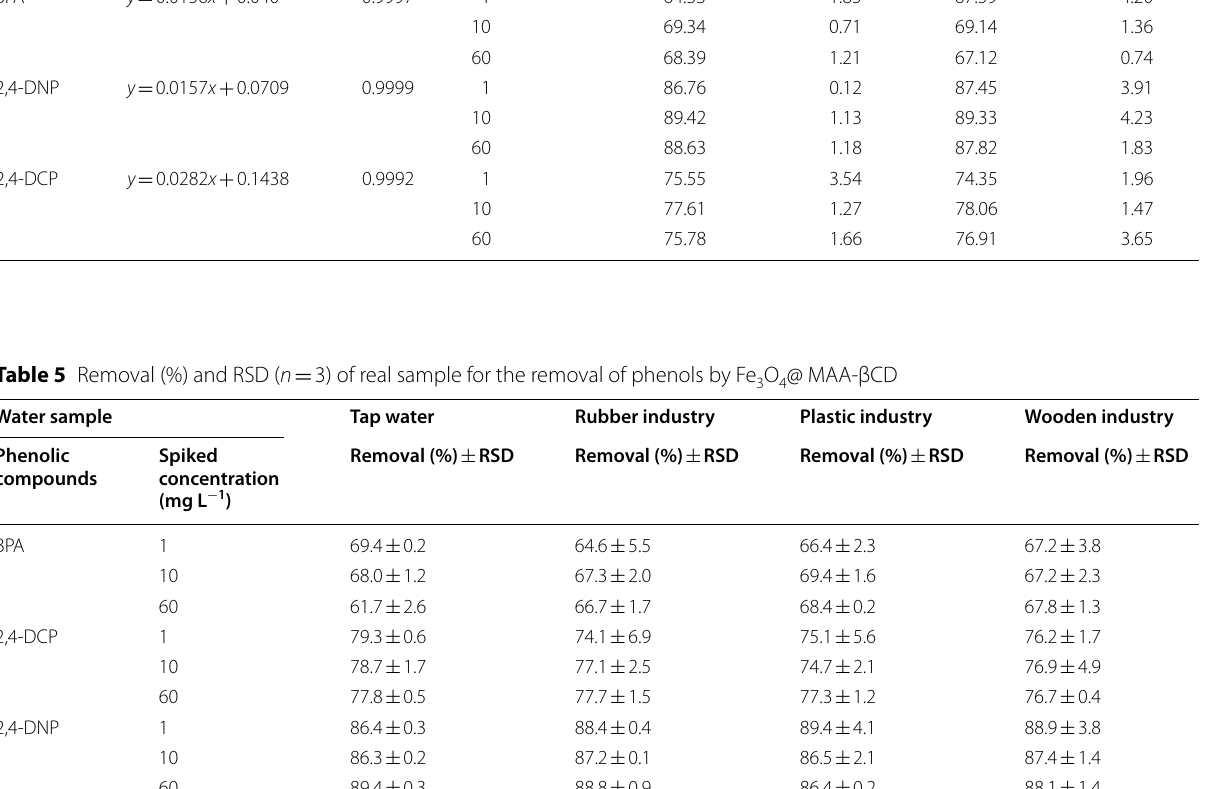
Table 4 Analytical performance data for the removal of selected phenolic compounds using UV–Vis spectrophotometry Analytes